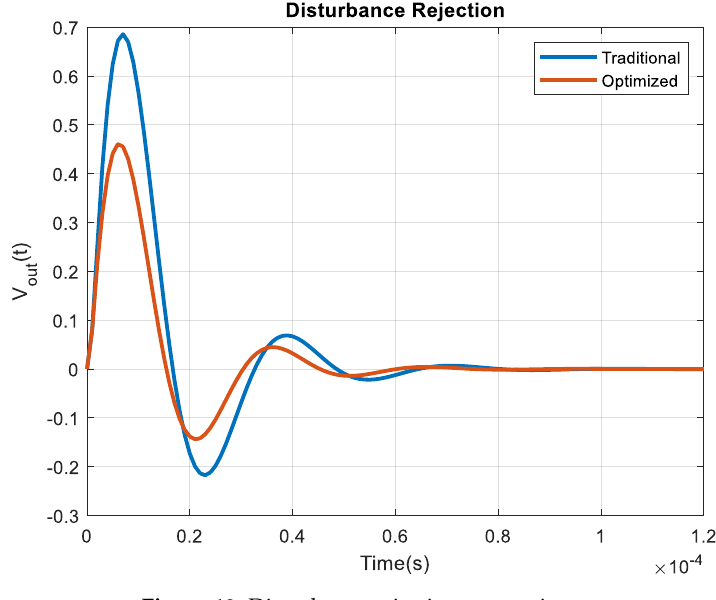
Figure 10. Disturbance rejection comparison. Electronics 2018 , 7 , x FOR PEER REVIEW Table 2. Controllers’ transfer functions.